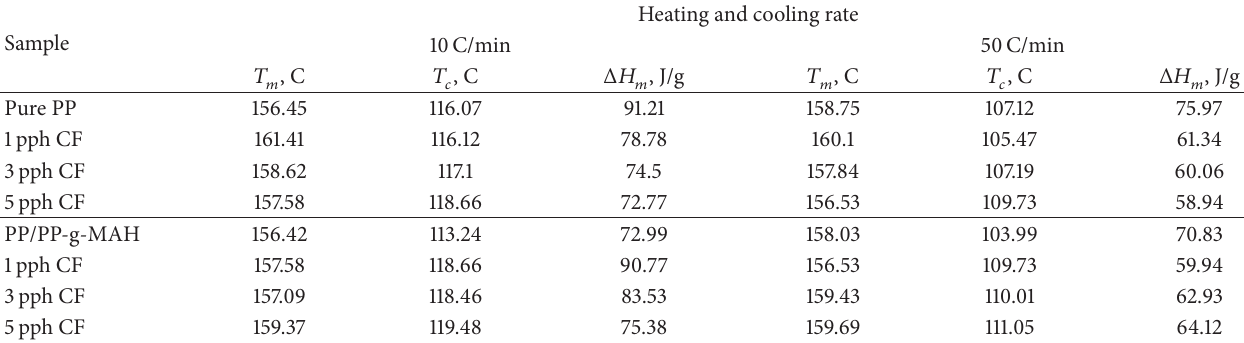
Table 1: Crystallisation properties of the samples.